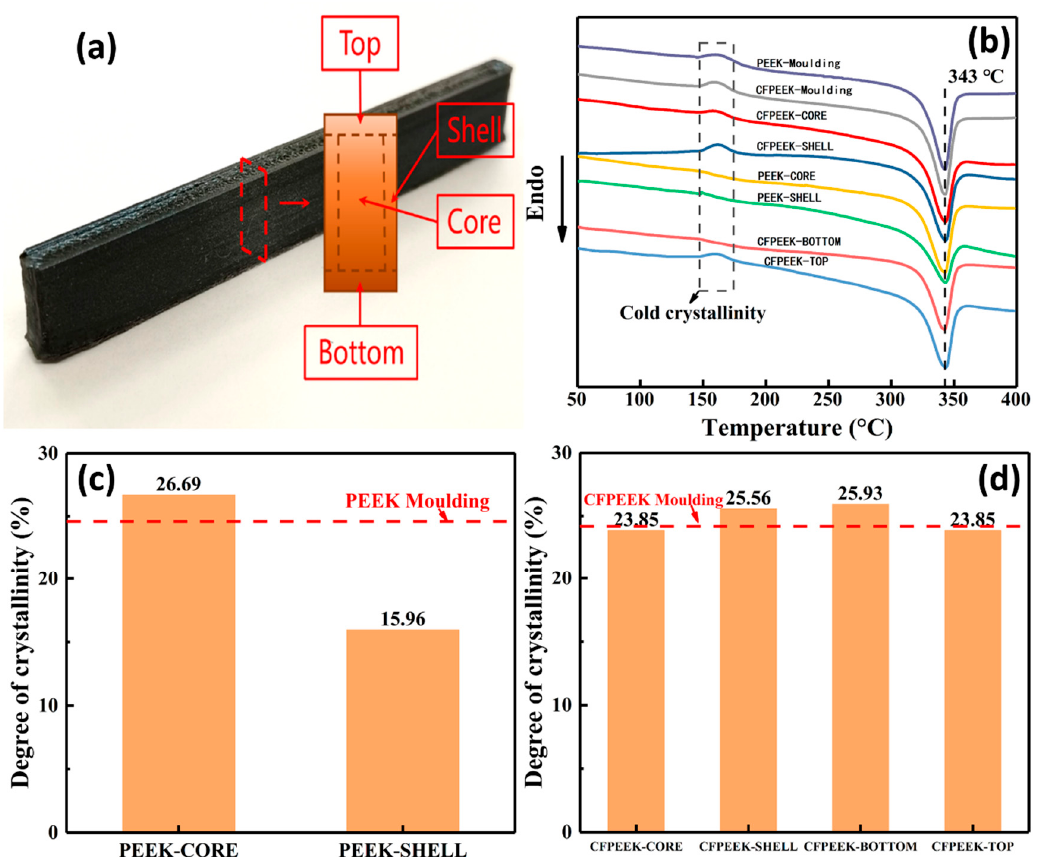
Figure 2. Differential scanning calorimetry (DSC) results of printed PEEK and CF/PEEK parts. ( a ) The position of DSC testing samples. ( b ) Heat flow curves of CF/PEEK and PEEK parts. ( c ) Otherness of crystallinity of shell and core of printed PEEK parts. ( d ) Corresponding crystallinity results of printed CF/PEEK parts.